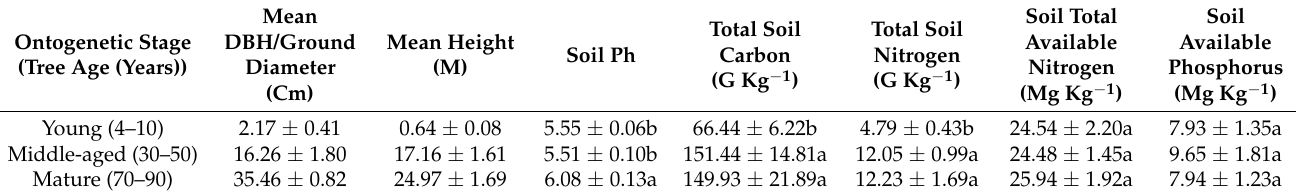
Table 1. Characteristics of sampled trees and soils (0–10 cm depth) in Fraxinus mandshurica at different ages. Ontogenetic Stage (Tree Age